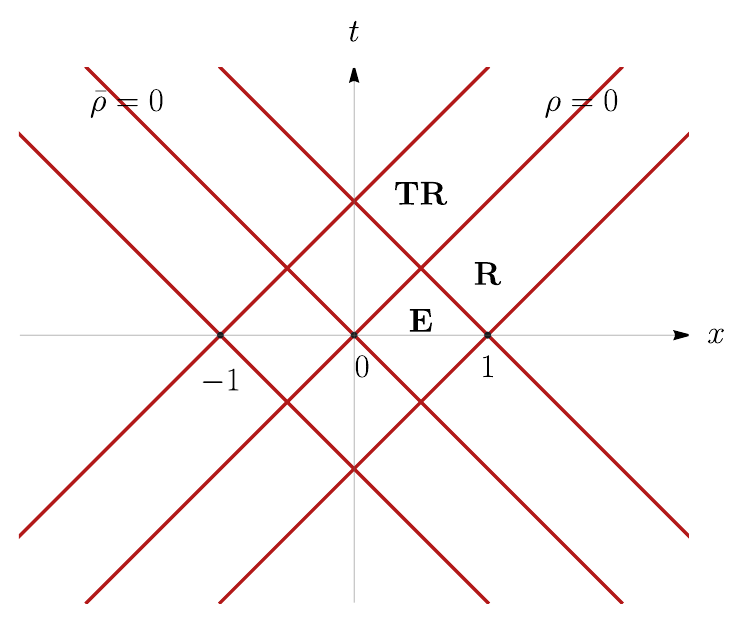
Figure 14 . Specification of E, R, and TR regions in ( t, x )